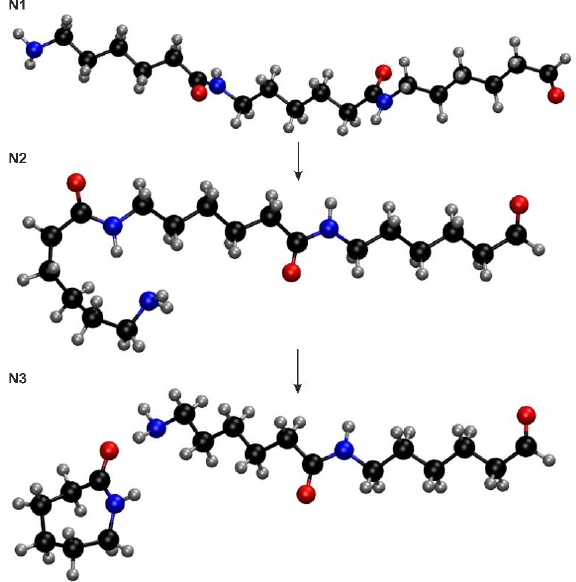
Figure 4. Chemical structure of the substrate (N1), intermediate structure (N2) and the final product (N3) of the nylon 6 thermal degradation process; the colors of the spheres are as follows: black — carbon, light grey — hydrogen, red — oxygen, blue — nitrogen.